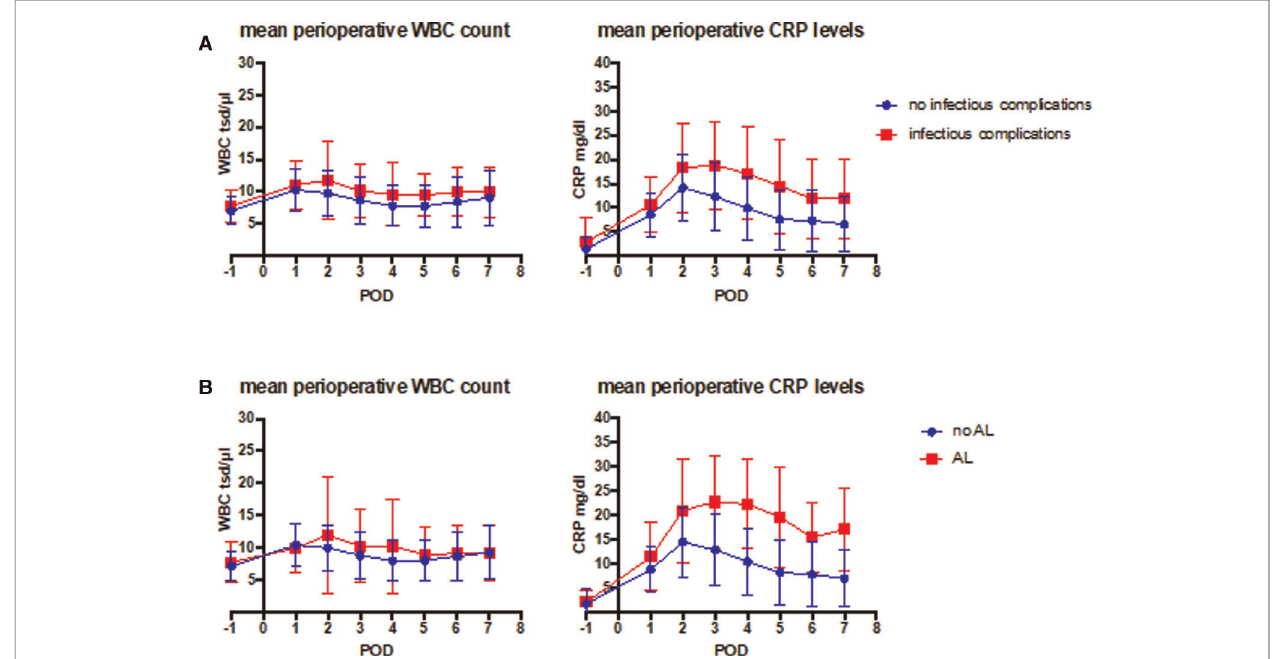
FIGURE 1 | Laboratory values such as white blood cell count (WBC) and C-reactive protein (CRP) were assessed perioperatively from the day before surgery until the 7th postoperative day. ( A ) Comparison of the course of parameters between patients with (red) and without (blue) infectious complications. ( B ) Comparison of the course of the parameters between patients with (red) and without (blue)